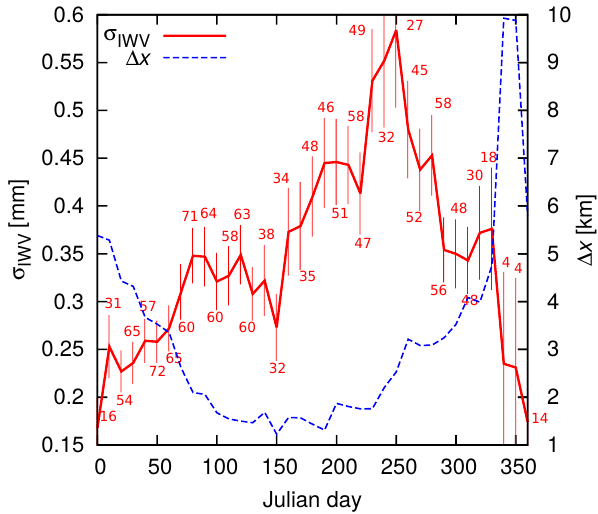
Figure 4. σ IWV as a function of a Julian day. The coincidence interval is 20min in this case; pairs within 30 days were taken into account. The quantity of measurement pairs from which σ IWV was calculated is indicated by the numbers near the curve. The dashed line shows the mean horizontal distance between the pair- wise soundings of IWV as a function of the season. The uncertain- ties ( ± σ ) are indicated by the error bars (for calculation see